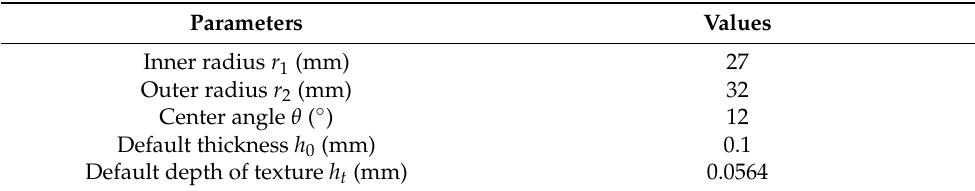
Table 2. Oil film model parameters.